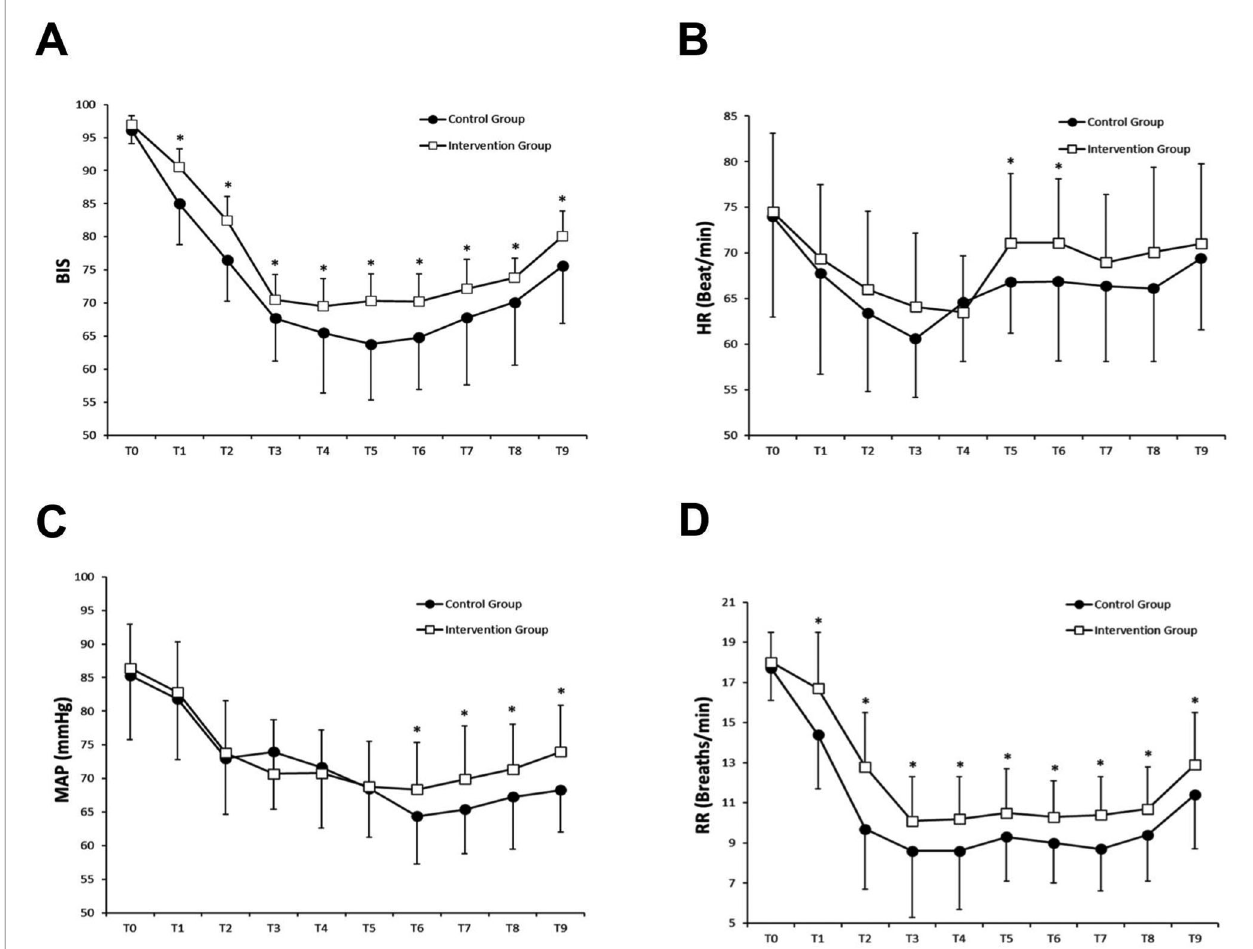
FIGURE 2 | Changes in BIS ( A ), HR ( B ), MAP ( C ) and RR ( D ) were compared by the independent sample t-test for comparisons between the two groups. * p <0.05 compared with the Control group.